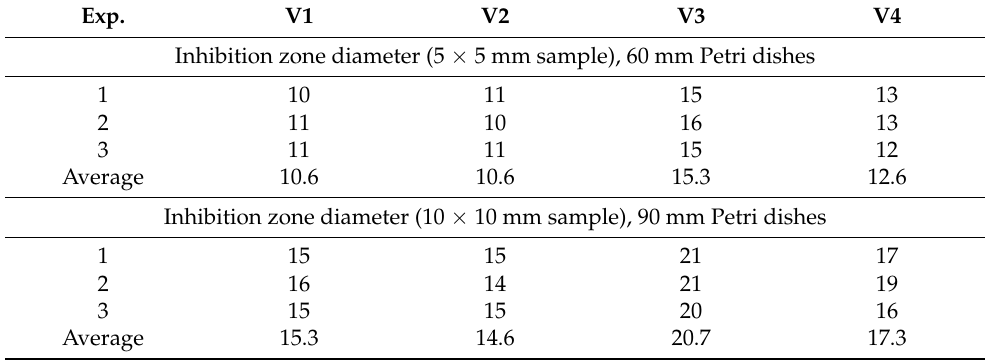
Figure 10. Inhibition of St. aureus by V1 – V4 film samples during Kirby – Bauer disk diffusion tests (24 h incubation at 37 °C). The sample V3 demonstrated maximum effect. Table 4. Inhibition of St. aureus by V1 – V4 film samples (by diameter of transparent area, mm). Exp.